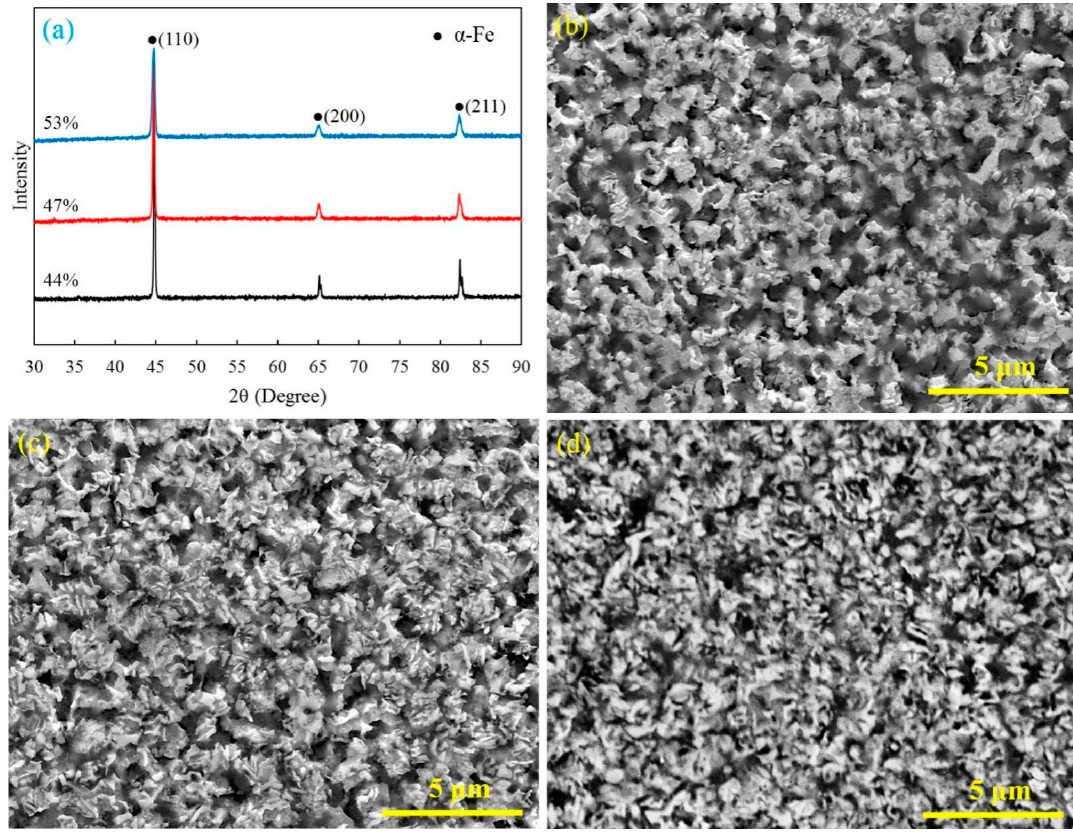
Figure 2. XRD pattern ( a ) and SEM micrographs of porous iron with different porosity: ( b ) 44%; ( c ) 47%; and ( d ) 53%.